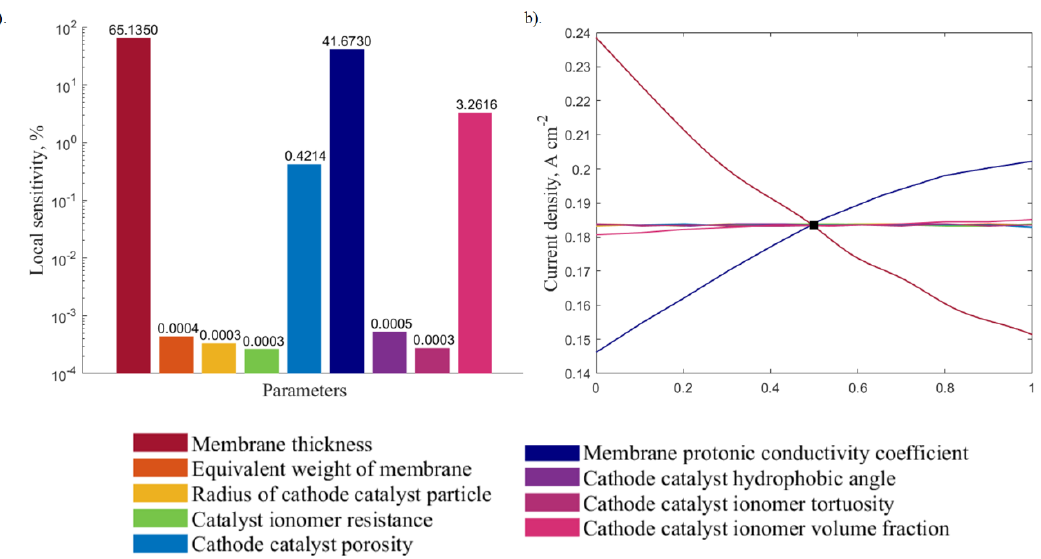
Figure 8. Local sensitivity analysis at 0.8 V presented in: ( a ) the bar plot and the ( b ) sensitivity curve.